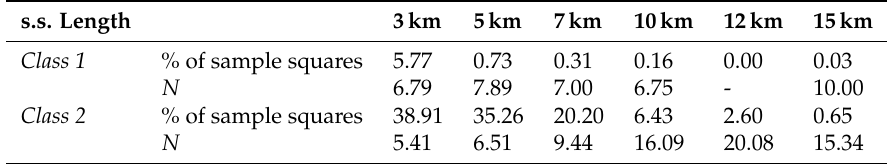
Table 2. For Class 1 and Class 2 in the data set Egypt, percentage of sample squares (s.s.) with ANN > 1.5 are listed; N is the average number of data points in these sample squares.